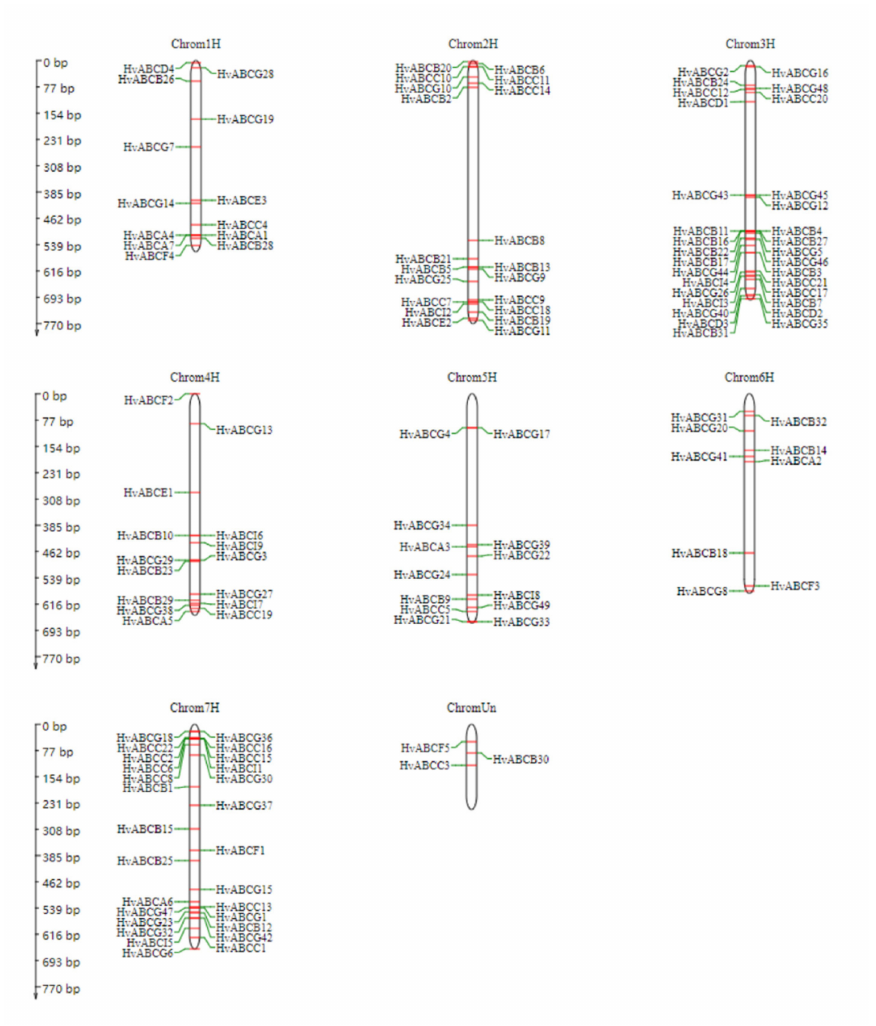
Figure 2. Mapping of the HvABC genes on Hordeum vulgare L. chromosomes. The chromosome number is indicated at the top of each chromosome. Three putative HvABC genes could not be localized on a specific